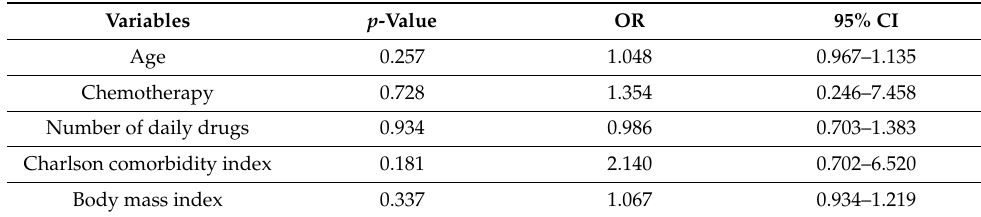
Table 3. Logistic regression model: clinical variables associated to the outcome variable (progression or not of frailty syndrome at